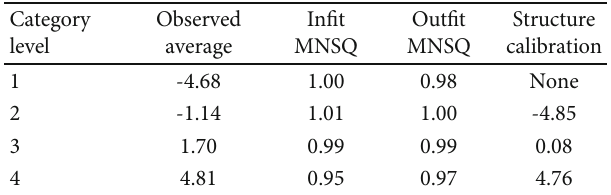
Table 2: Summary of the rating scale analysis of original 4-point